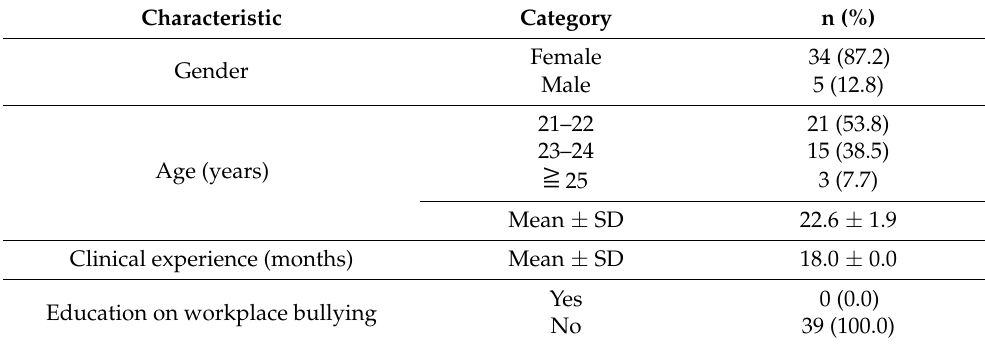
Table 2. Participants’ characteristics ( N = 39).